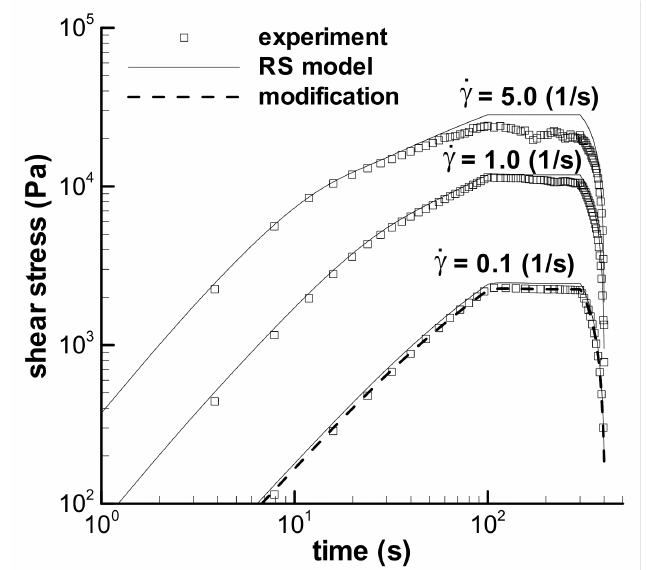
Figure 12. Predictions of the trapezoidal-loop experiments with the maximum shear rates of 0.1 s − 1 , 1 s − 1 and 5 s − 1 , t 0 = 100 s and t 1 = 200 s. Solid line is the calculation by the RS model, and dashed line is the modification with f = 0.899 in Table 4.